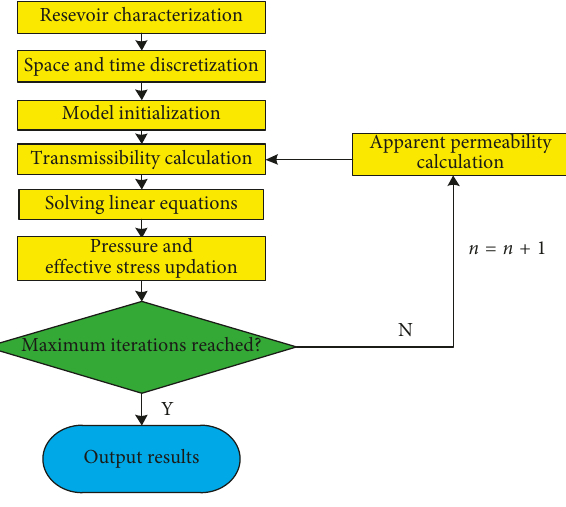
Figure 8: Numerical simulation process. Table 2: Gas reservoir parameters for validation.